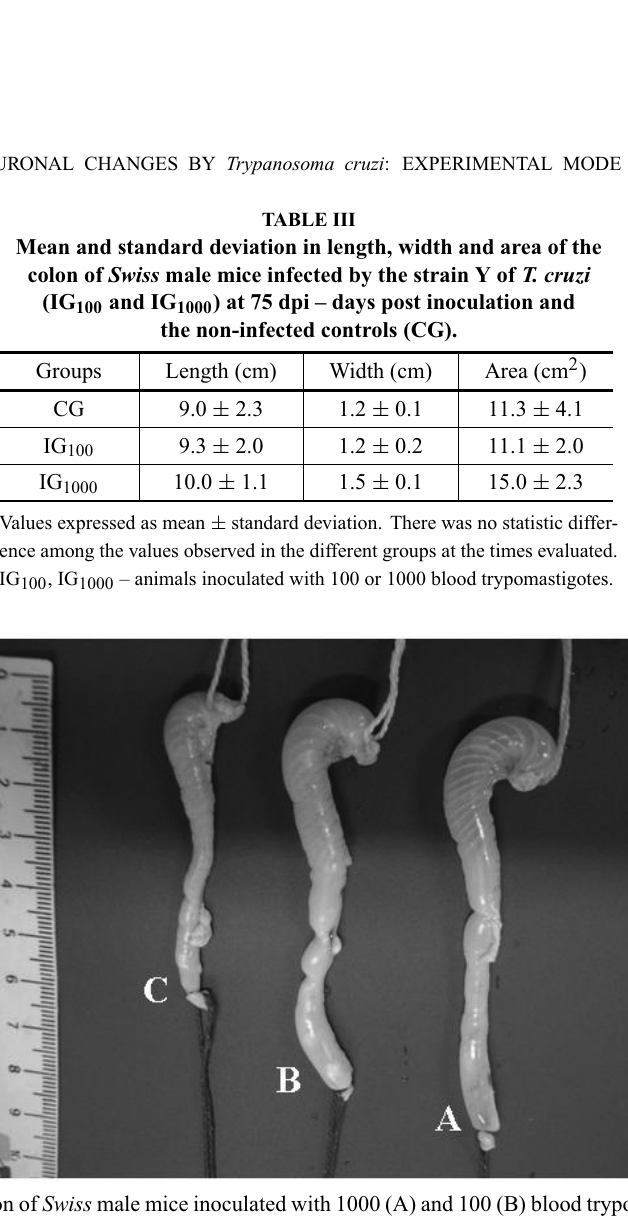
Fig. 2 – Colon of Swiss male mice inoculated with 1000 (A) and 100 (B) blood trypomastigotes from the strain Y of T. cruzi at 75 dpi – days post inoculation and the non-infected controls